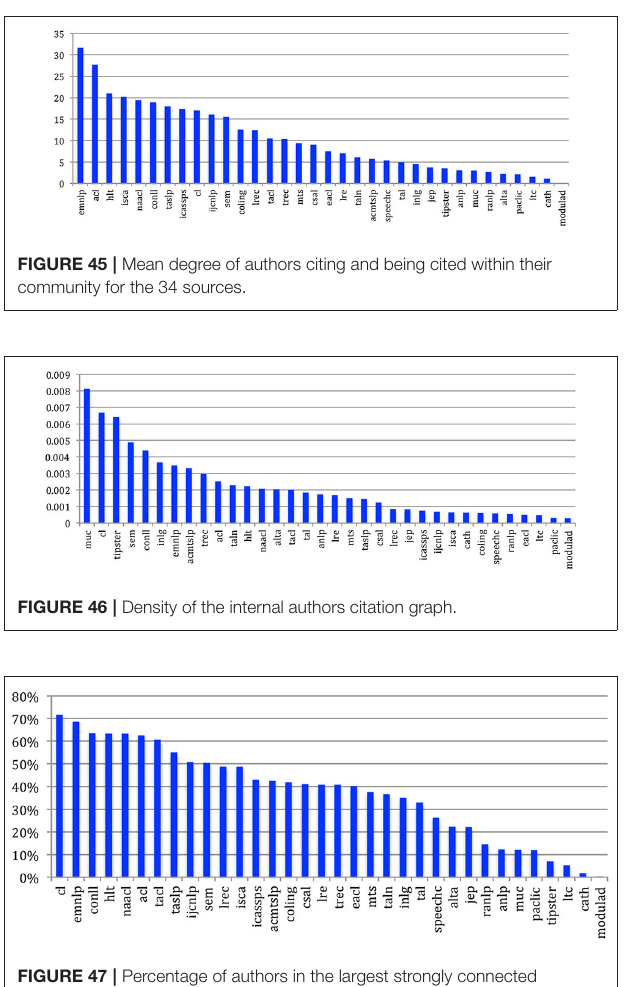
FIGURE 49 | Mean degree of authors citing authors in general for the 34